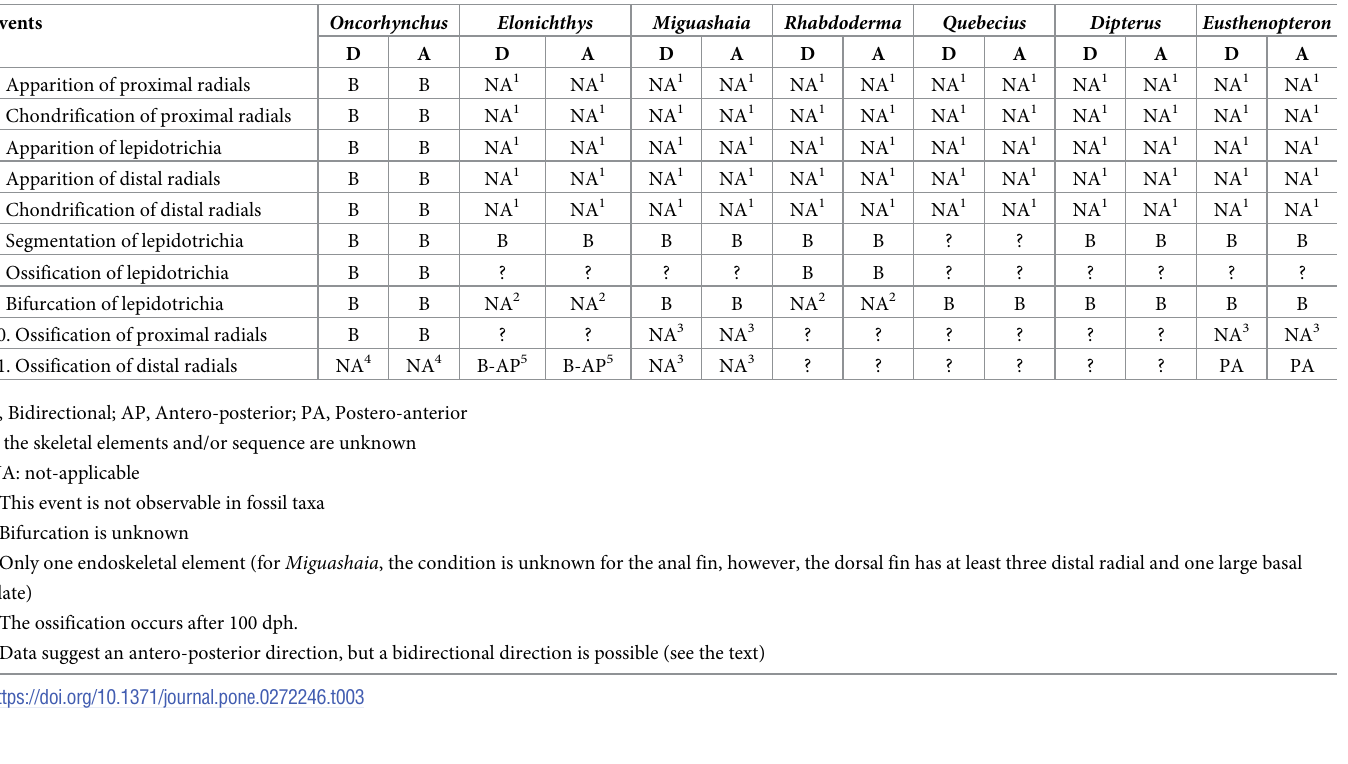
Table 4. Spearman correlations between developmental sequences of (a) the dorsal and anal fins and (b) fin exo- skeleton and endoskeleton of the dorsal (D) and anal (A) fins of O . mykiss to validate the presence of the DAFPM and the EEM respectively. See Nomenclature for the complete list of